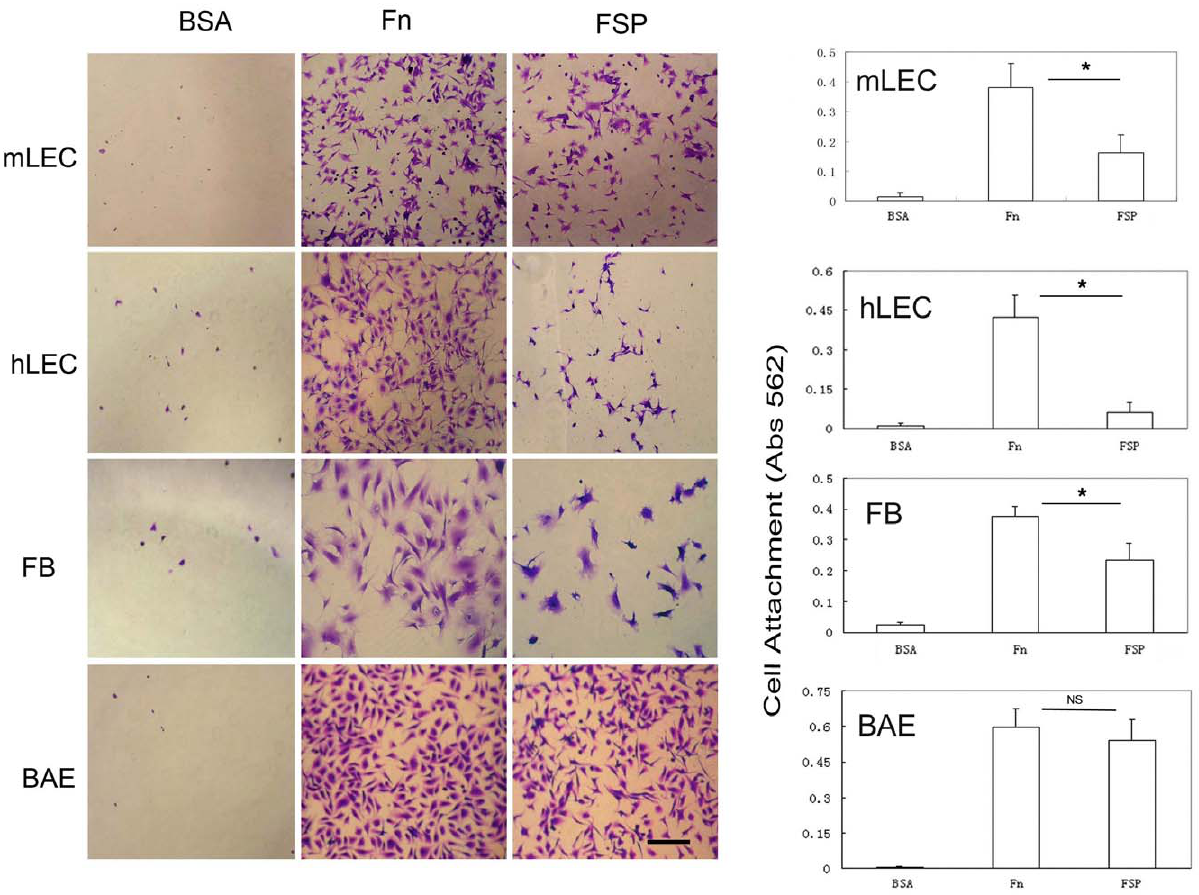
Figure 3. FSP supports cell attachment and spreading. BSA, FSP, and Fn were coated onto wells overnight at 4 u C. mLEC, hLEC, murine fibroblasts (FB), and BAE cells were plated into each well in serum-free DMEM, and allowed to attach for 2 hr at 37 u C. Cells were stained with 0.1% crystal violet, and representative photographs are shown of cells on each substrate. Cell attachment was also quantified by a colorimetric assay (right panel). The absorbance at 562 nm was correlated directly with the number of cells bound to the substrate. Bars represent the mean + / 2 SD of three experiments carried out in triplicate. * P , 0.05; NS, not significant. Scale bar=50 um for all photographs.